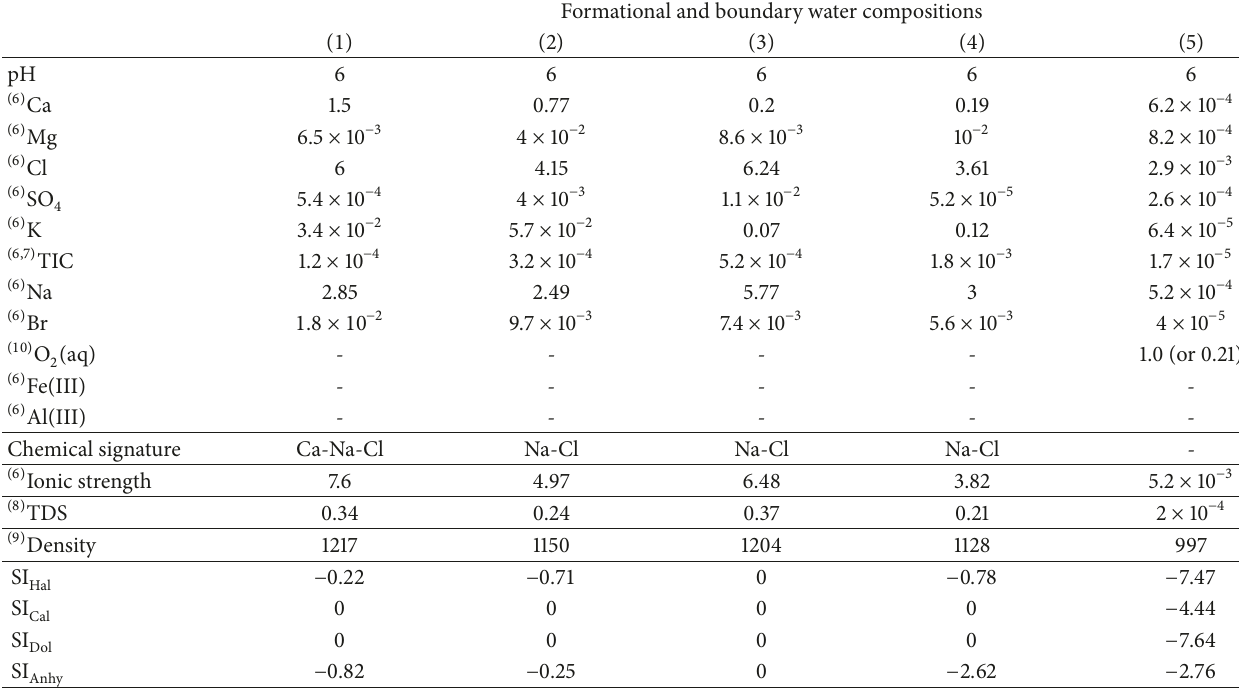
Table 4: Chemical composition of brines and brackish waters considered in the reactive transport simulations (chemical compositions taken from Hobbs et al.